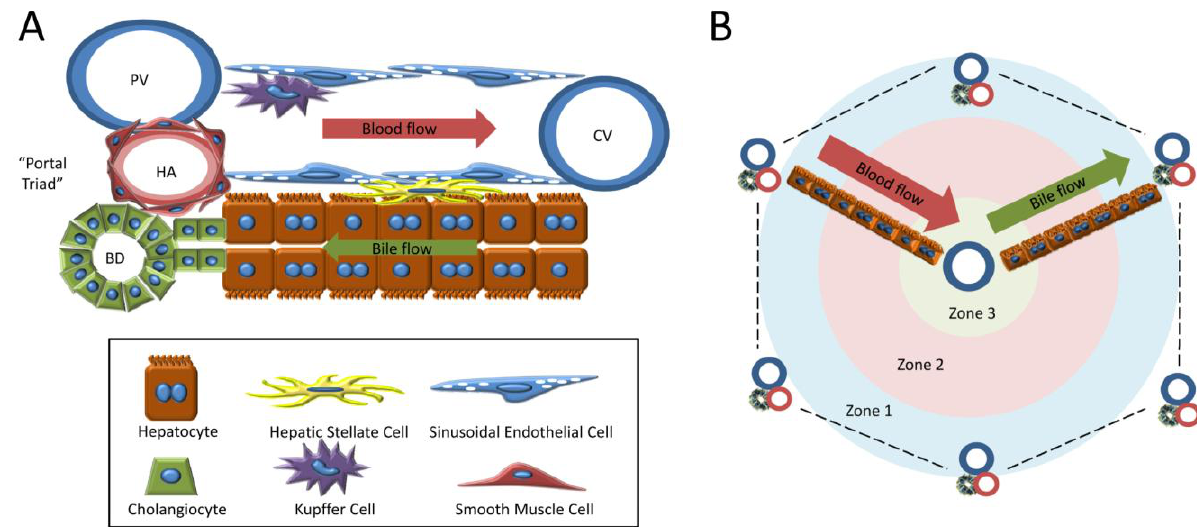
Figure 1. Architecture of the liver. (a) Schematic depicting the architecture and cell type composition of the hepatic sinusoid. Blood enters the lobule from branches of the portal vein (PV) and hepatic artery (HA) and progresses through the sinusoidal capillaries, collecting at the central veins (CV). Bile flows in the opposite direction towards the portal triad and exits through the bile ducts (BD). Hepatocytes are lined up along the sinusoids in (cid:179)(cid:83)(cid:79)(cid:68)(cid:87)(cid:72)(cid:86)(cid:180)(cid:3) (cid:20) -2 hepatocytes thick. Hepatic stellate cells reside in between the sinusoidal (cid:72)(cid:81)(cid:71)(cid:82)(cid:87)(cid:75)(cid:72)(cid:79)(cid:76)(cid:68)(cid:79)(cid:3) (cid:70)(cid:72)(cid:79)(cid:79)(cid:86)(cid:3) (cid:68)(cid:81)(cid:71)(cid:3) (cid:75)(cid:72)(cid:83)(cid:68)(cid:87)(cid:82)(cid:70)(cid:92)(cid:87)(cid:72)(cid:86)(cid:3) (cid:76)(cid:81)(cid:3) (cid:87)(cid:75)(cid:72)(cid:3) (cid:179)(cid:86)(cid:83)(cid:68)(cid:70)(cid:72)(cid:3) (cid:82)(cid:73)(cid:3) (cid:39)(cid:76)(cid:86)(cid:86)(cid:72)(cid:180) . (b) Diagram illustrating the organization of the hepatic lobule, including vascular structures and relative zonality of the lobule. This unit is repeated throughout the liver. Representative plates of hepatocytes are shown for orientation; these rows of hepatocytes would fill the entire lobule and be lined with